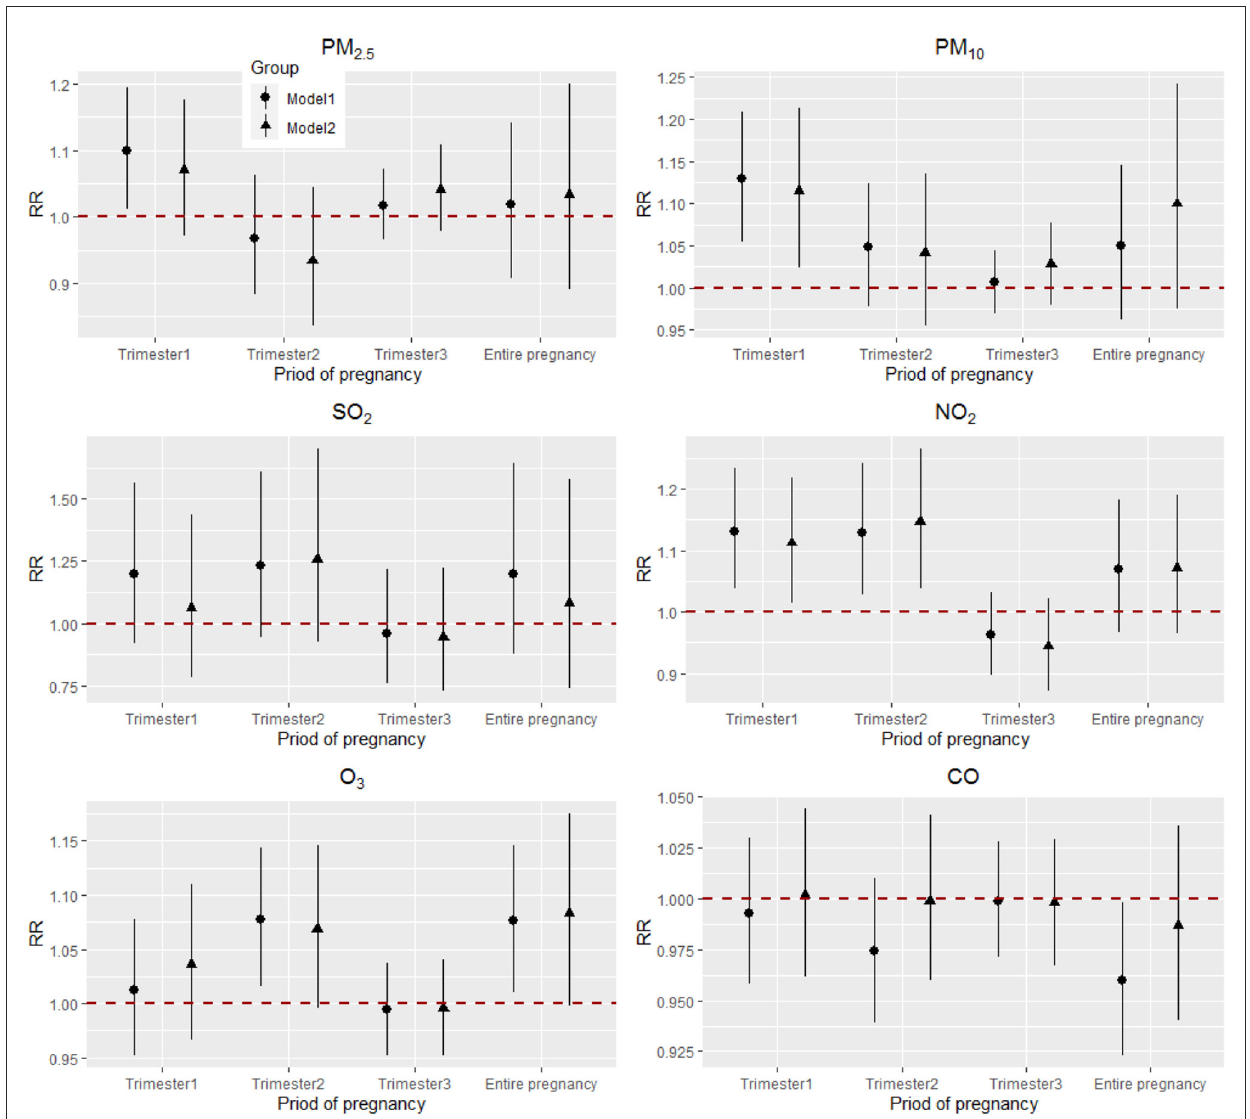
FIGURE2 Adjusted RRs (95% CIs) for VLBW associated with air pollutants during the different stages of pregnancy in Model 1 and Model 2. Model 1: single-pollutant model, adjusted for covariates including mean temperature and humidity, age of mother and father, and age of gestation, as represented by a circle; Model 2: multi-pollutant model, adjusted for covariates including mean temperature and humidity, age of mother and father, weight of birth, and additionally adjusted for other air pollutants, as represented by a triangle.